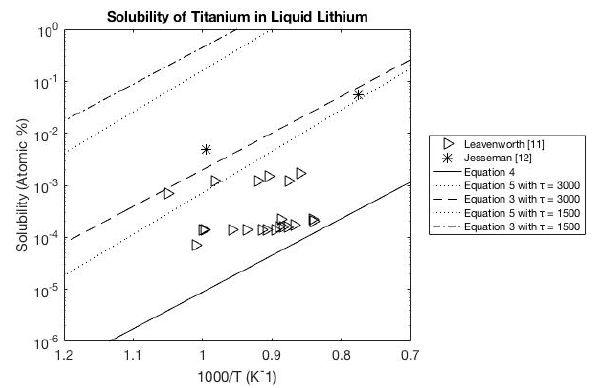
Figure 2. The solubility of titanium in liquid lithium.